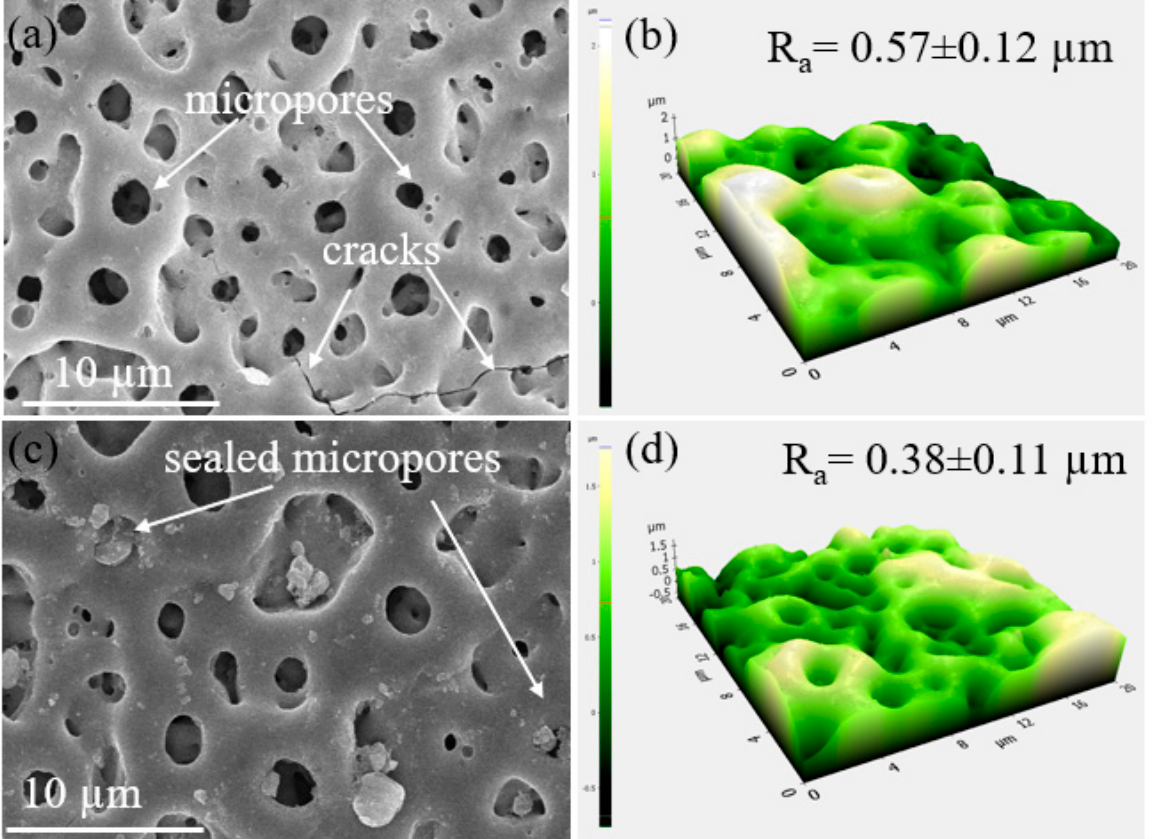
Figure 2. SEM and corresponding AFM analysis on the surface of the S1 and S2 samples. The images showed the presence of micropores and cracks on the ( a , b ) S1 and ( c , d ) S2 samples.